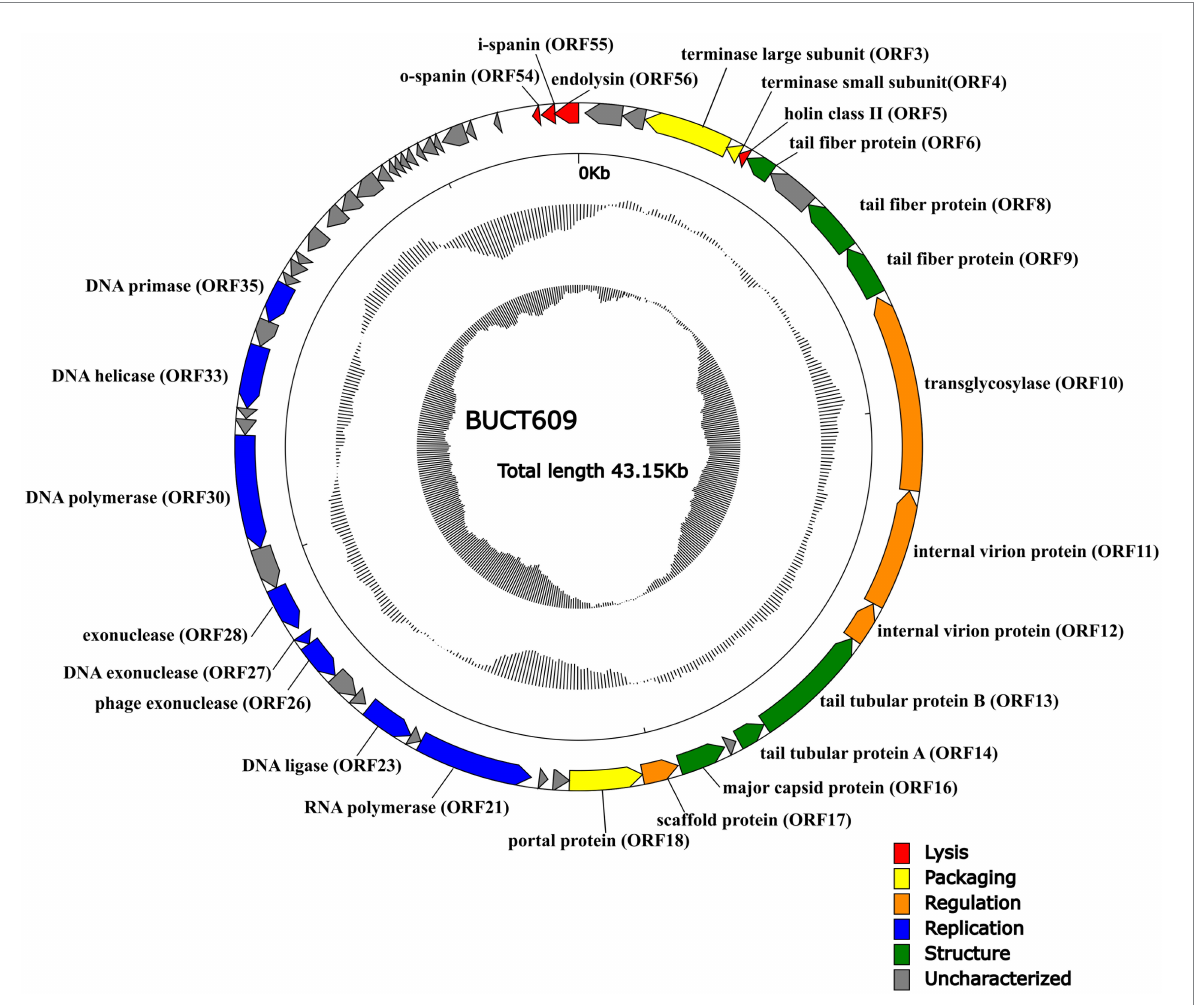
FIGURE 3 The whole genetic map of phage BUCT609. The outermost circle represents the open reading frame. Colors distinguish different functional genes while arrows represent ORF directions. The middle circle represents (G + C) mol% (outwards larger than the whole-genome average (G + C) mol%, inwards the opposite). The innermost circle represents the G + C tilt of G − C/G + C (outward for greater than 0 and inward for less than